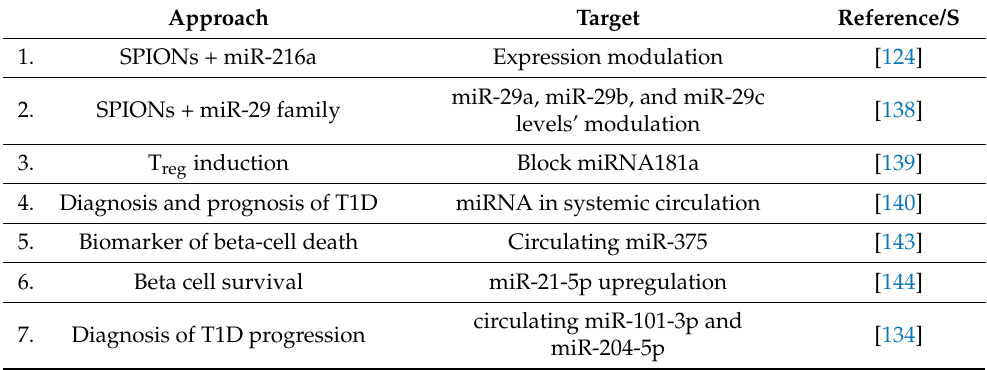
Table 4. Summary of strategies for targeting microRNAs towards